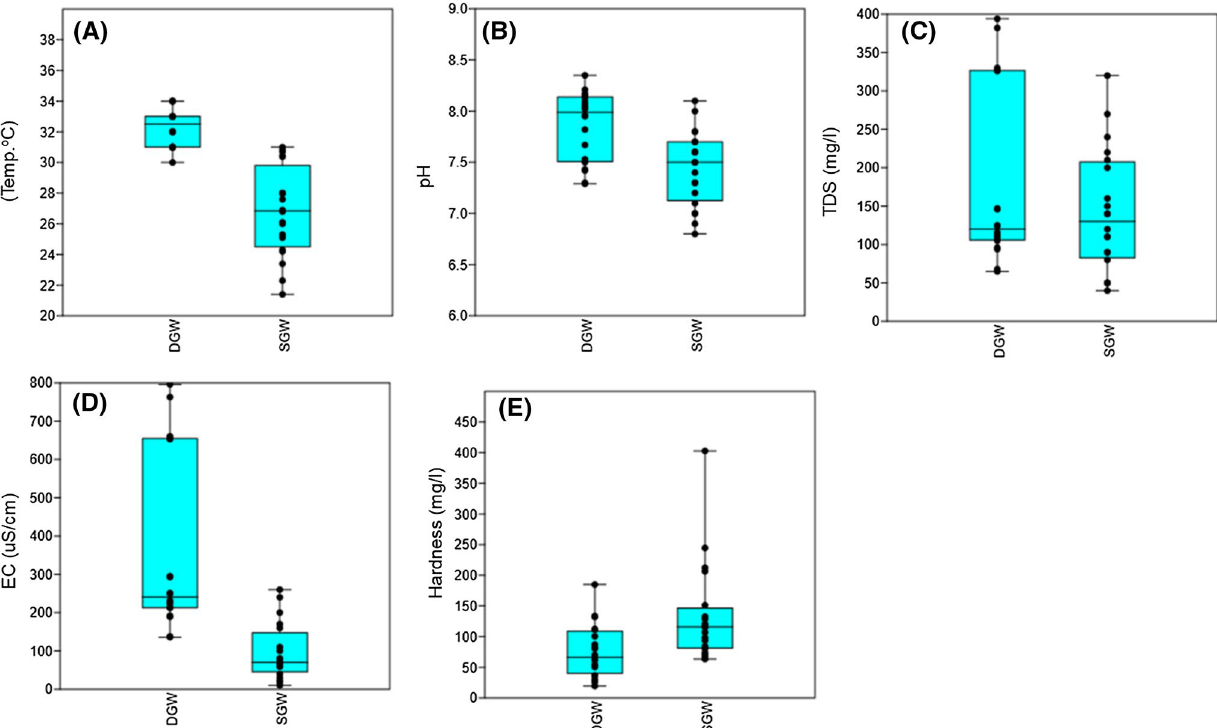
Fig. 5 Variability in physical parameters between deep and shallow groundwater a temperature; b pH; c EC, d TDS; and e hardness. DGW deep groundwater, SGW shallow